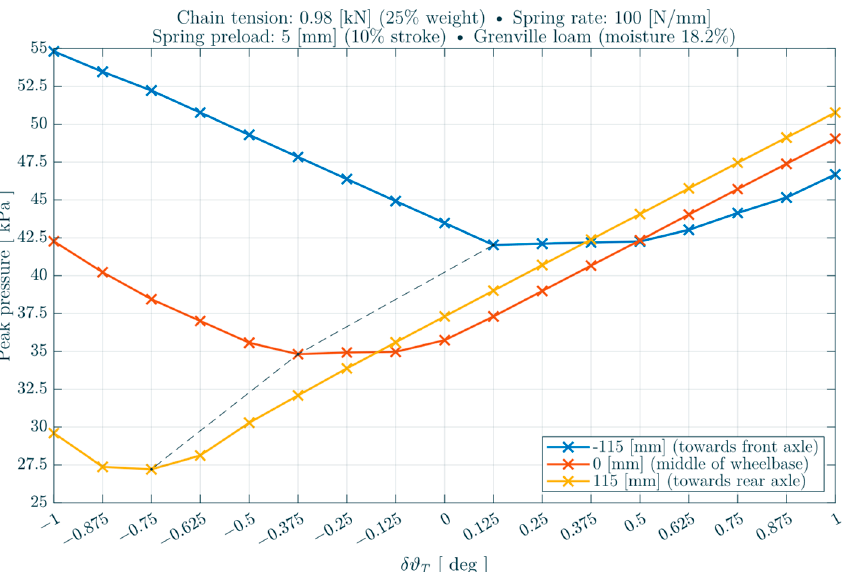
Figure 25. Peak pressure beneath the track module as a function of δϑ T : center of gravity position effect.